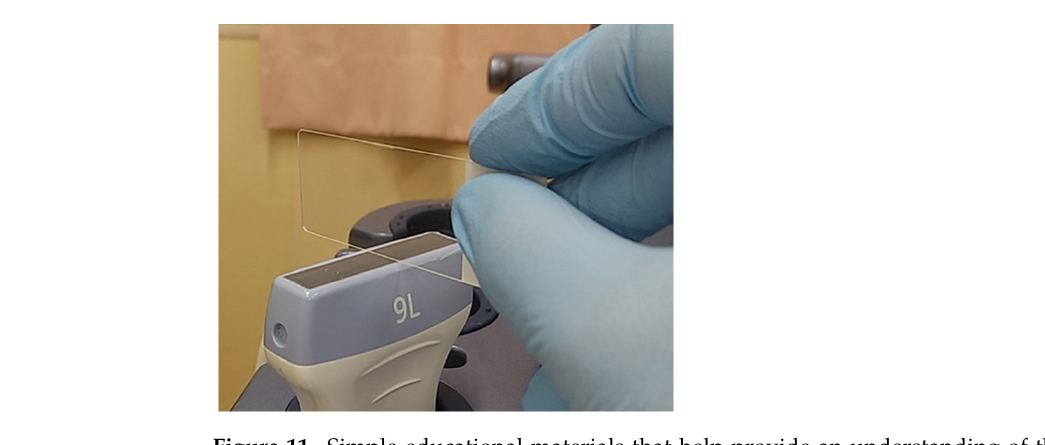
Figure 12. Ultrasound images obtained with the. linear transducer. The vertical artifact becomes wider as the focal point (arrow) is moved to deeper levels ( a – e ). When spatial compound imaging is enabled, the single vertical artifact changes to three lines radiating from the same point ( a , f ). The three lines become wider as the focal point (arrow) is moved to deeper levels ( f – j ).